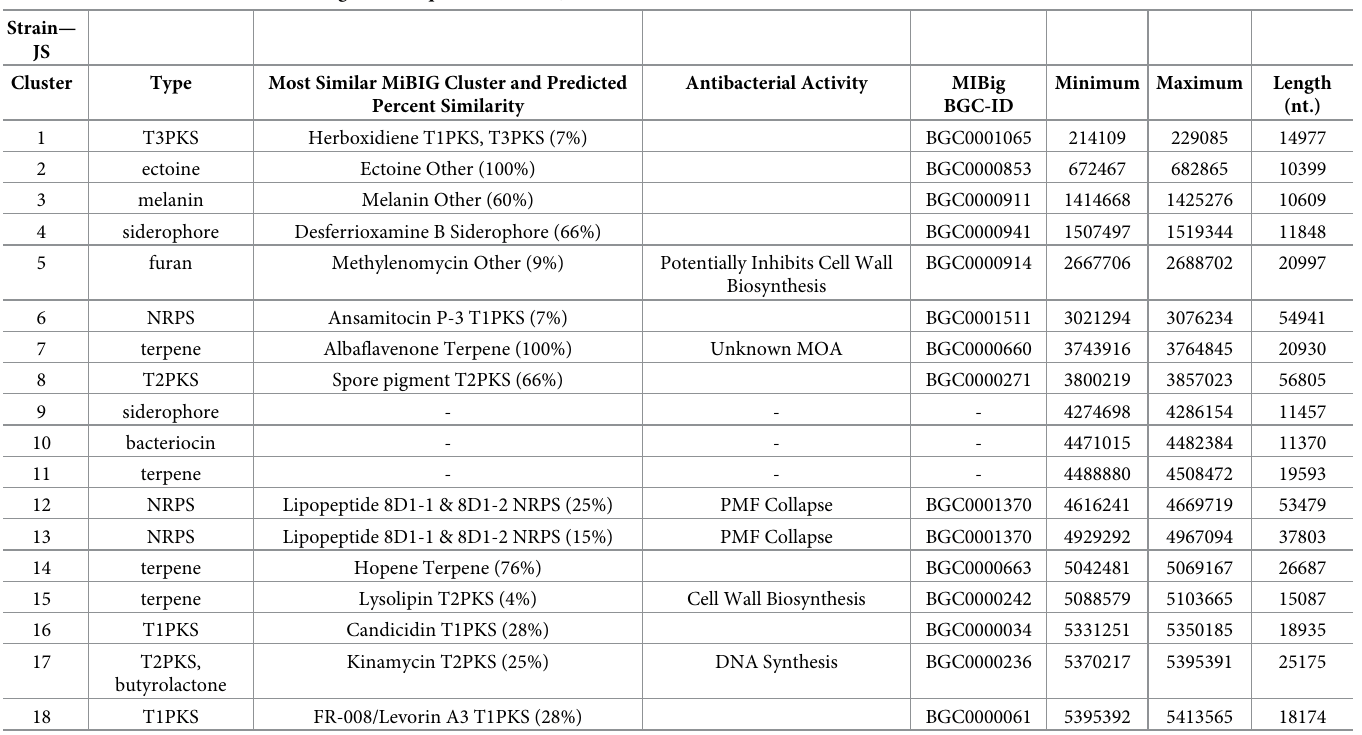
Table 3. BGCs encoded within the draft genome sequence of strain